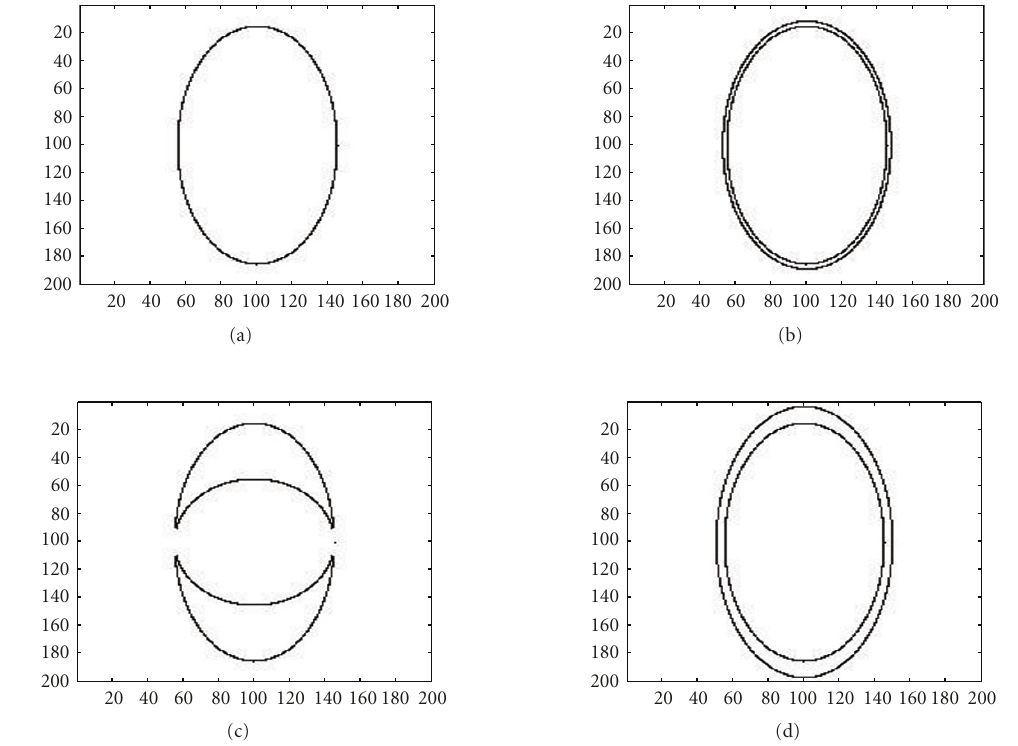
Figure 8: Ellipse fitting: (a) processed. (b) Di ff erence processed and result by the existing method for ellipse retrieval [6]. (c) Di ff erence processed and result by the GHT. (d) Di ff erence processed and result obtained after applying the proposed